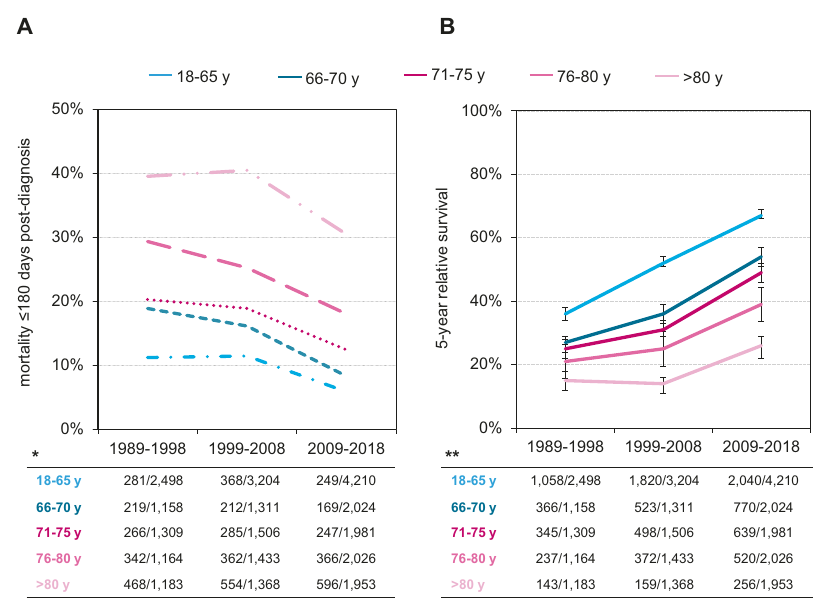
**Numberof patientsaliveat 5 yearspost-diagnosis/totalnumberof patients Fig. 1 Trends in relative survival and early mortality of patients with multiple myeloma (MM) in the Netherlands, 1989 – 2018. A shows the trend in early mortality ≤ 180 days post-diagnosis according to age for the three consecutive calendar periods (1989 – 1998, 1999 – 2008, and 2009 – 2018). The absolute numbers of patient with early mortality ≤ 180 days post-diagnosis and the total number of patients per age group and calendar period are presented in the table below. B shows the 5-year relative survival estimates for MM patients diagnosed